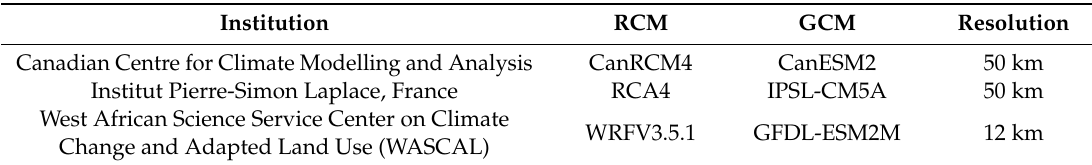
Table 1. Regional climate models (RCMs) and the forced global climate models (GCMs) used in this